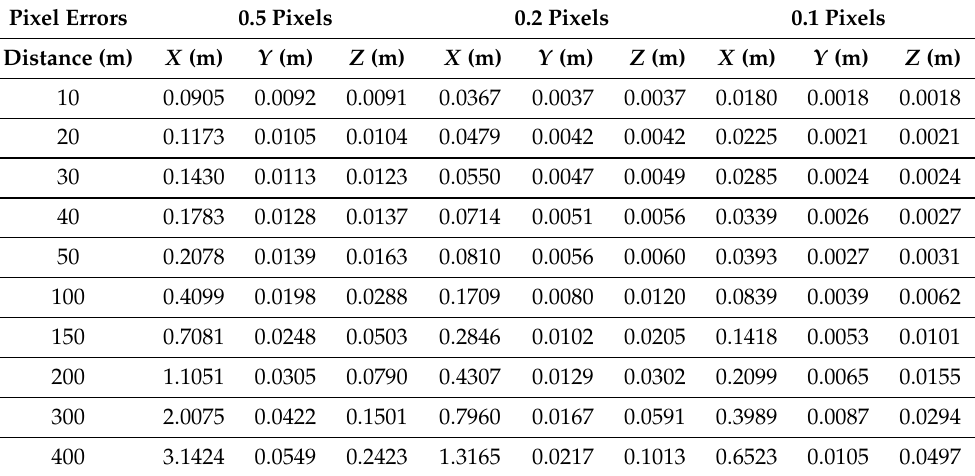
Table 7. The effect of the detection error on localization